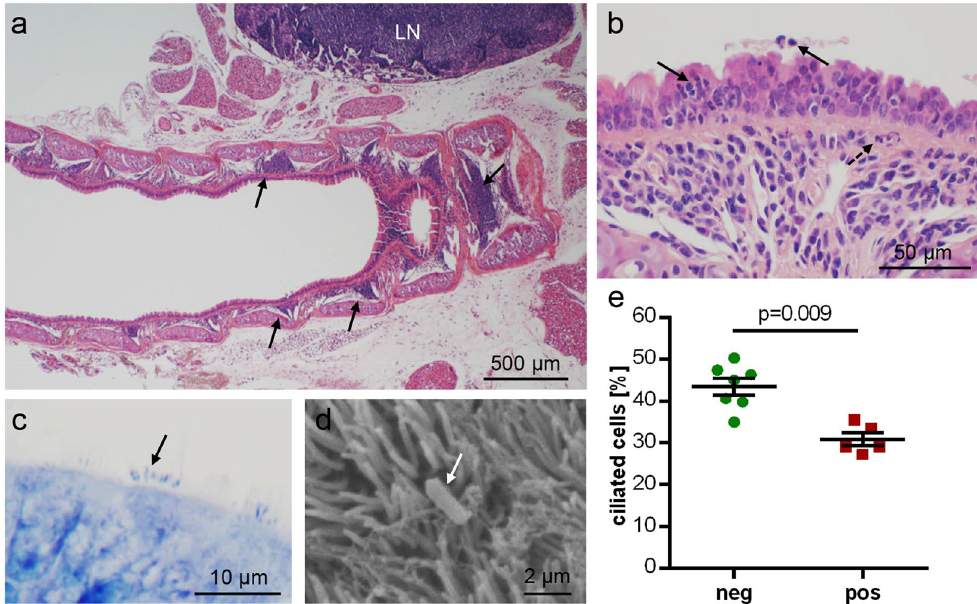
Figure 3. Tracheal histopathology in B. pseudohinzii -infected mice; micrographs are taken from animals which were negative for Pasteurella pneumotropica . ( a , b ) H&E-stained paraffin section. ( a ) Arrows point at focal infiltrations in the lamina propria in a longitudinal section. LN = adjacent lymph node with lymphoid hyperplasia. ( b ) Neutrophilic granulocytes ( arrows ) have invaded and penetrated the epithelial layer. Broken arrow indicates neutrophil accumulation underneath the basal lamina. ( c , d ) Rod-shaped bacteria ( arrows ) are attached to kinocilia, as seen in a Giemsa-stained paraffin section ( c ) and in scanning electron microscopy ( d ). ( e ) The relative frequency of ciliated cells among epithelial cells, as evaluated in H&E-stained paraffin sections, is significantly reduced in B. pseudohinzii -positive (pos; n = 5) compared to B. pseudohinzii -negative mice (neg; n = 7). Individual data points shown; horizontal bar and whiskers indicate mean and standard error of the mean (Student’s unpaired